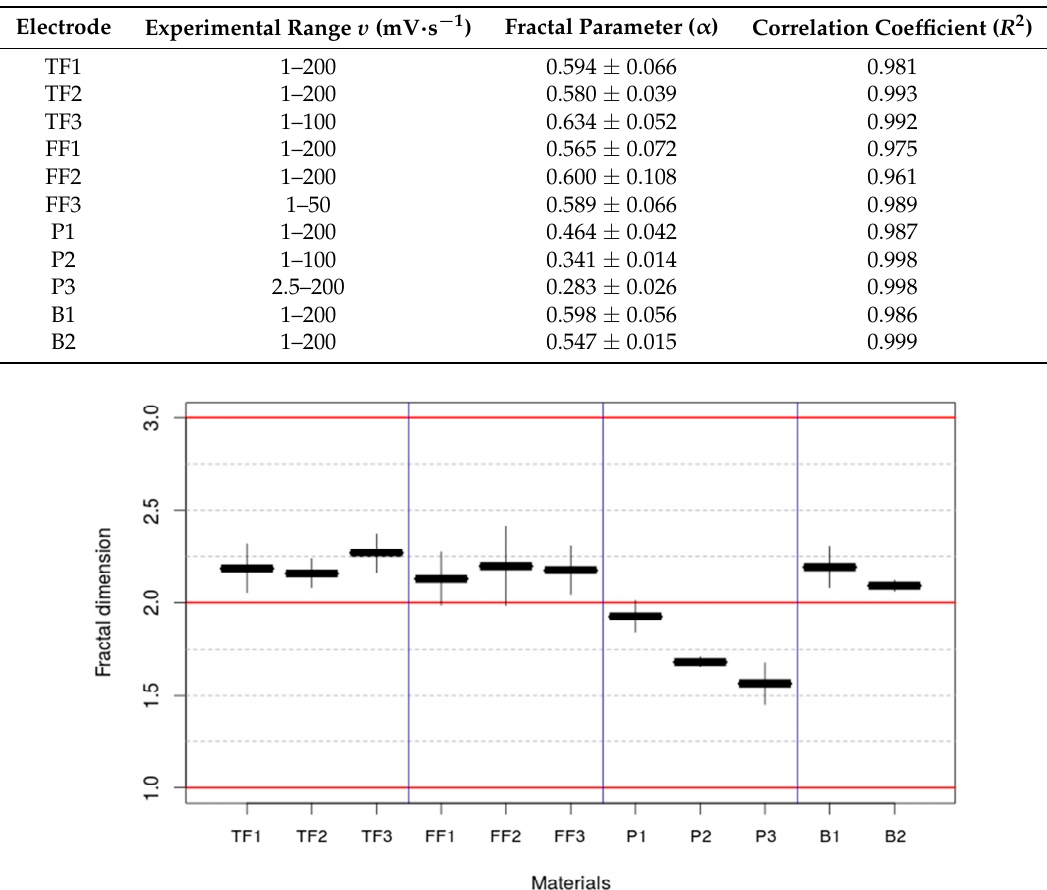
Table 4. Fractal parameter comparison of different electrodes using CV measurements. The value presented alongside the fractal parameter α represents the 90% confidence intervals for each estimated parameter.